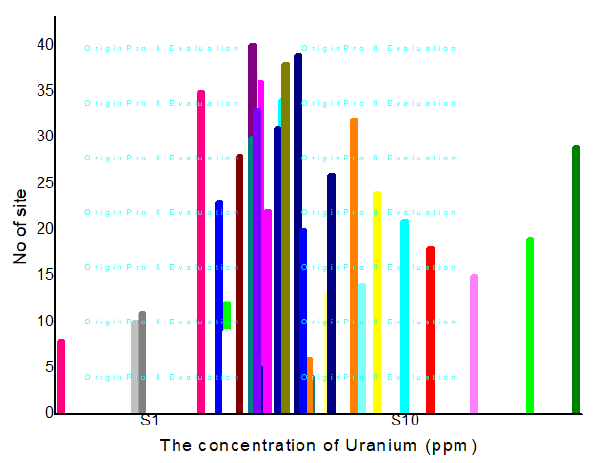
Fig. 2. The average uranium content in soil samples as a function of geographic location During the Gulf conflicts, human activity and the exposure of certain industrial zones to